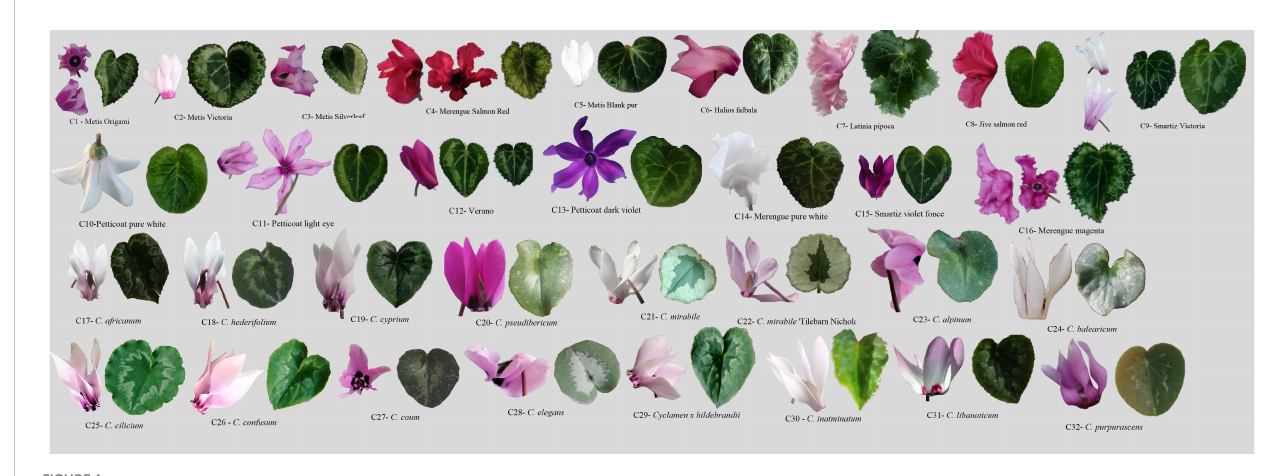
FIGURE 1 Cyclamen genotypes used in the study. Lane C1-C16, C. persicum cultivars, C17-C32, different Cyclamen